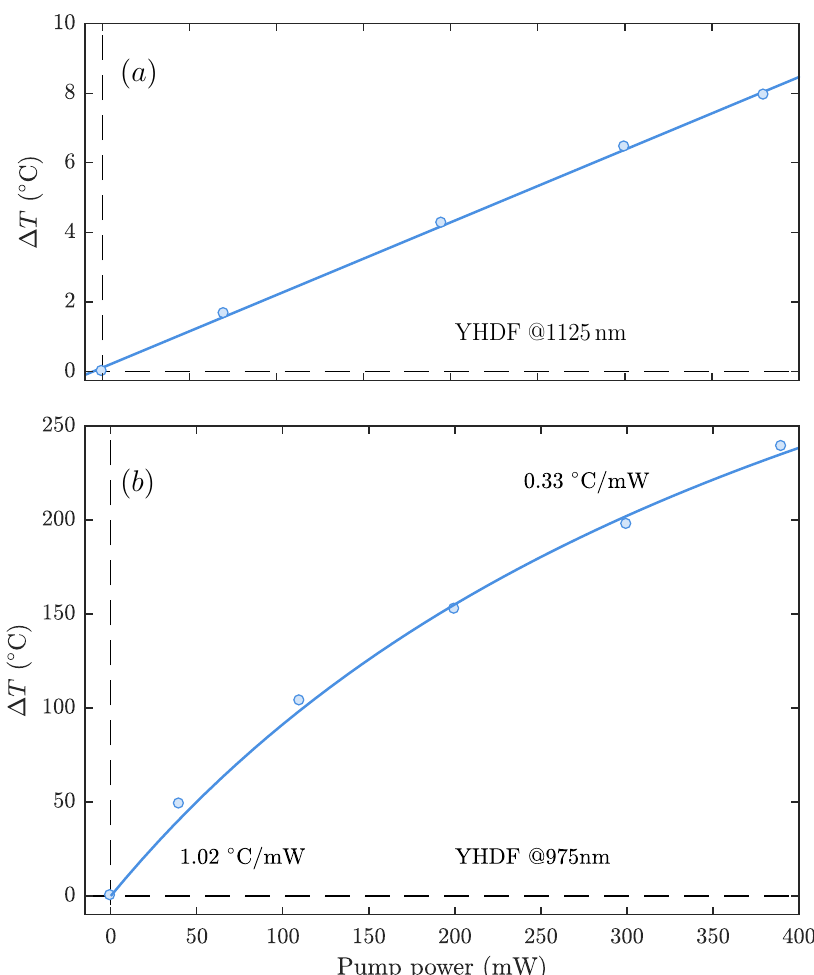
Figure 5. Temperature increment of the ytterbium-holmium codoped fiber (YHDF) as function of the pump signal at two different wavelengths: ( a ) at 1125nm; ( b ) at 975nm. Circles and curves show experimental points and fits,